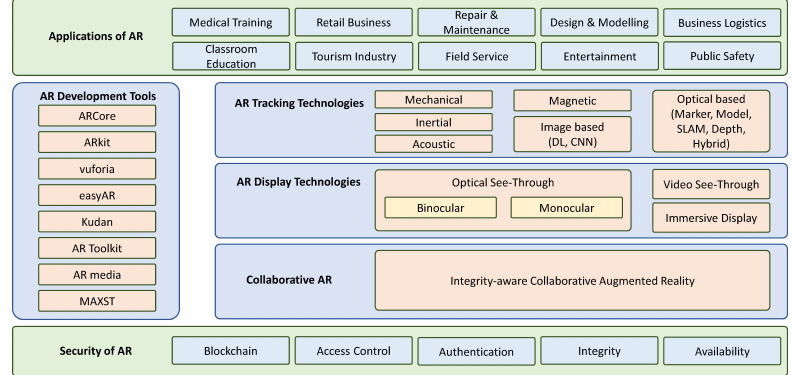
Figure 1. Overview of AR, VR, and collaborative AR applications, tools, and